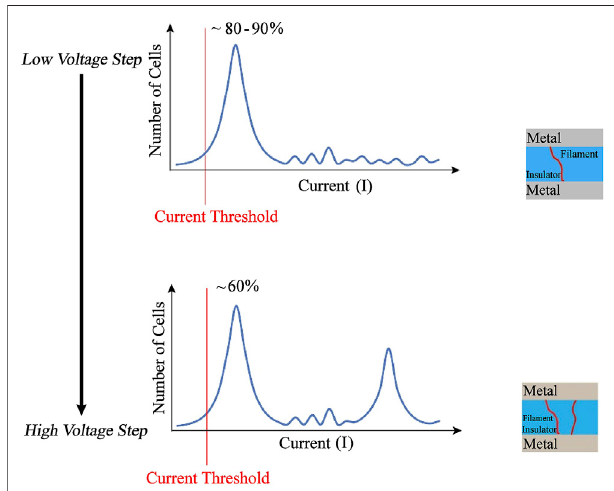
FIGURE 10 | Current distribution for set operation with incremental voltage step. In the top curve, a lower incremental step is used as in the bottom. This fi gure is depicted based on Figure 6 in the work of Pérez et al. (2017).